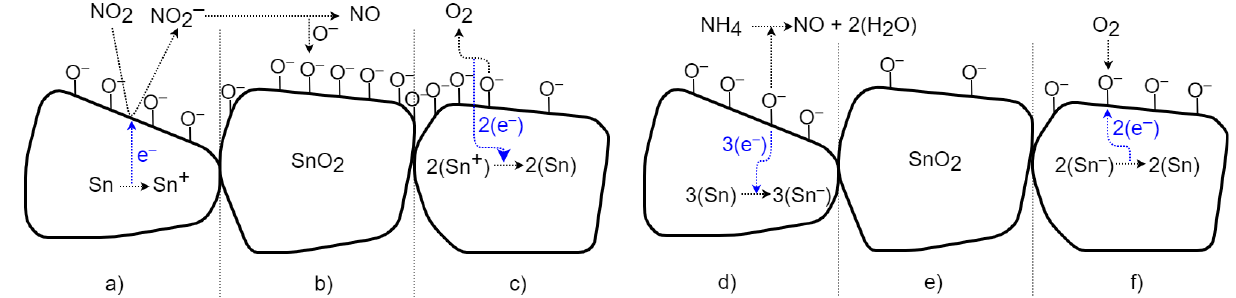
Figure 14. Schematic time process of gas interaction between the SnO 2 material and oxidizing and reducing gases.